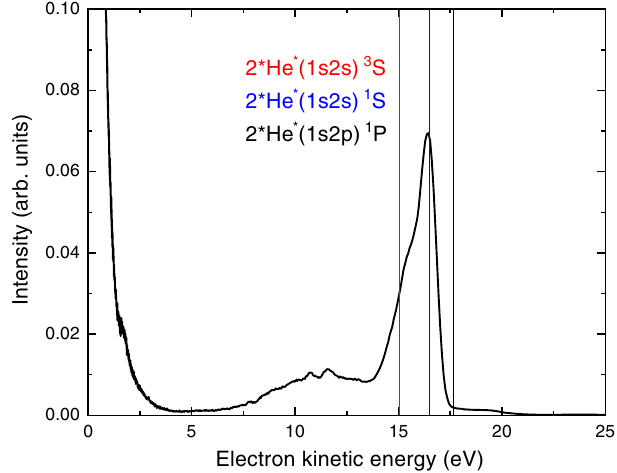
FIG. 5. Static (XUV only) electron kinetic energy distribution measured at h ν ¼ 23 . 7 eV. The vertical lines depict the nominal values of ICD electron energies for pairs of He (cid:2) atoms in the three lowest excited